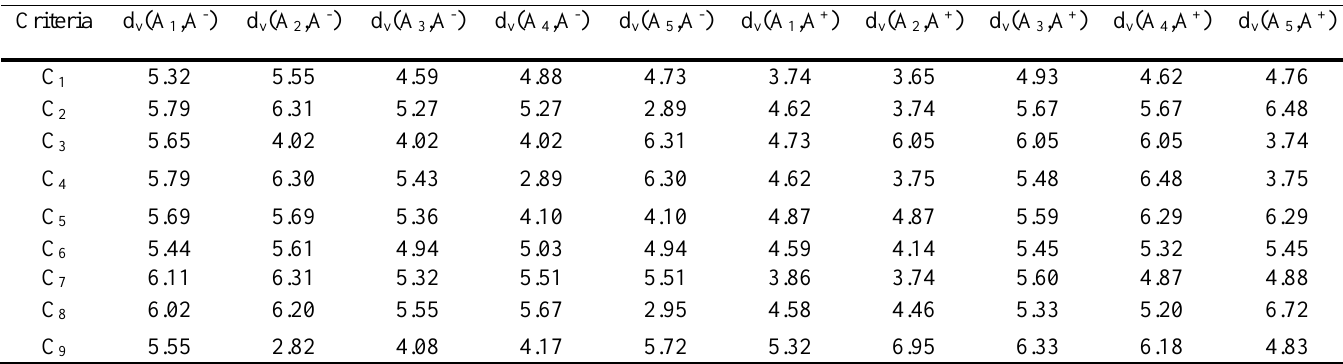
Table 9. Distances for alternatives .